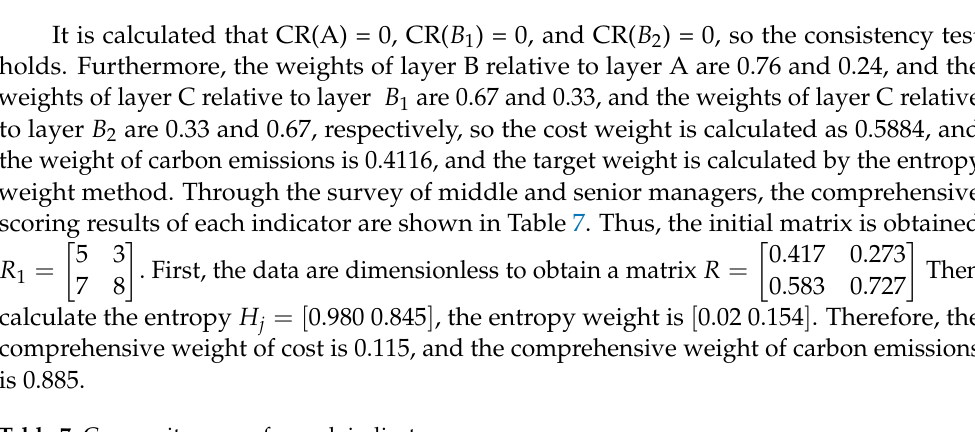
Table 7. Composite scores for each